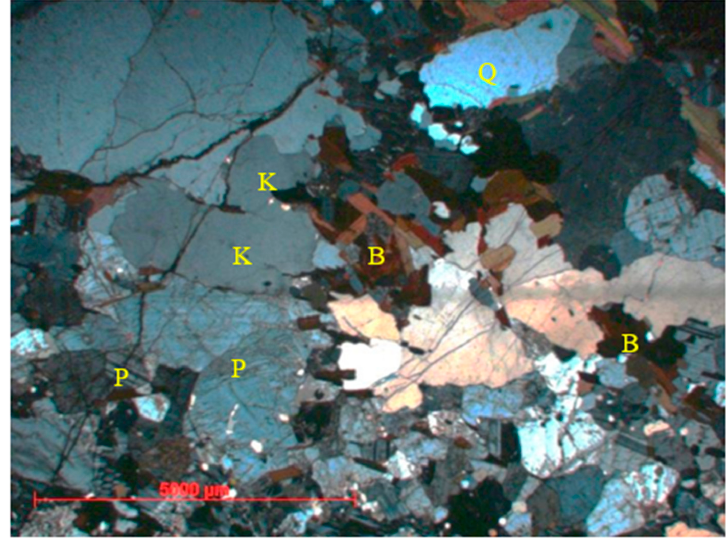
Figure 7. Photomicrograph of the stone sample taken by cross polarized light showing porphyroclastic texture and microcracks. Mineral abbreviations: Q, quartz; K, K-feldspar; P, plagioclase; and B, biotite.